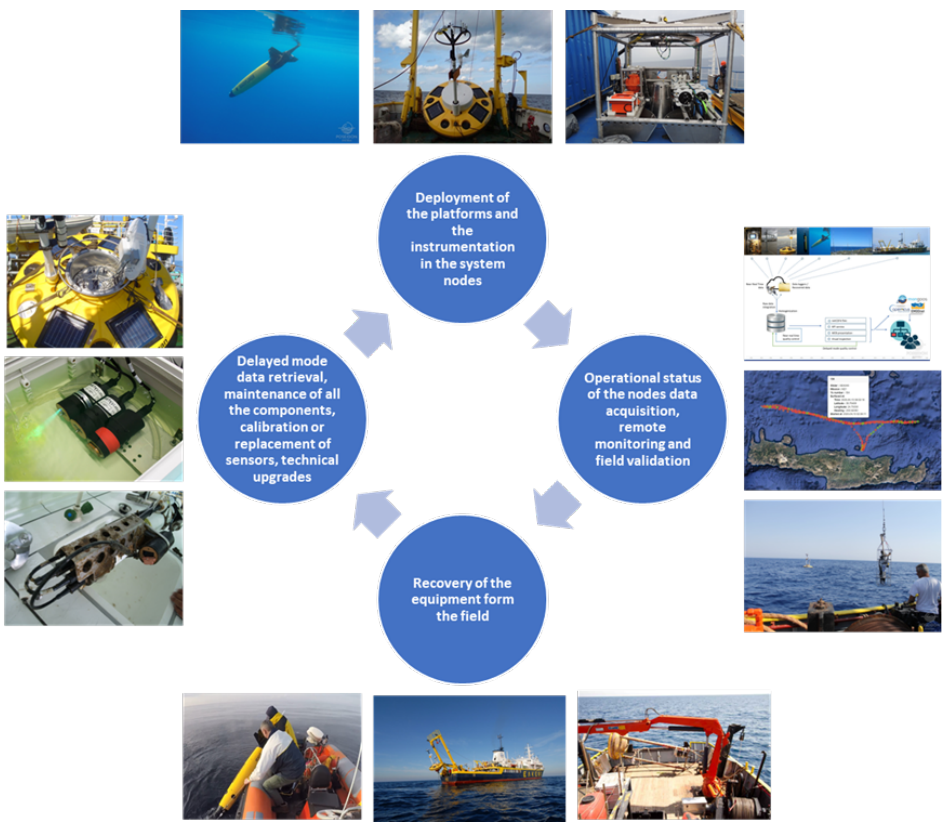
Figure 4. The operational scheme of the POSEIDON system. Table 3. The frequency of maintenance, the duration and the supporting means required per platform of the POSEIDON